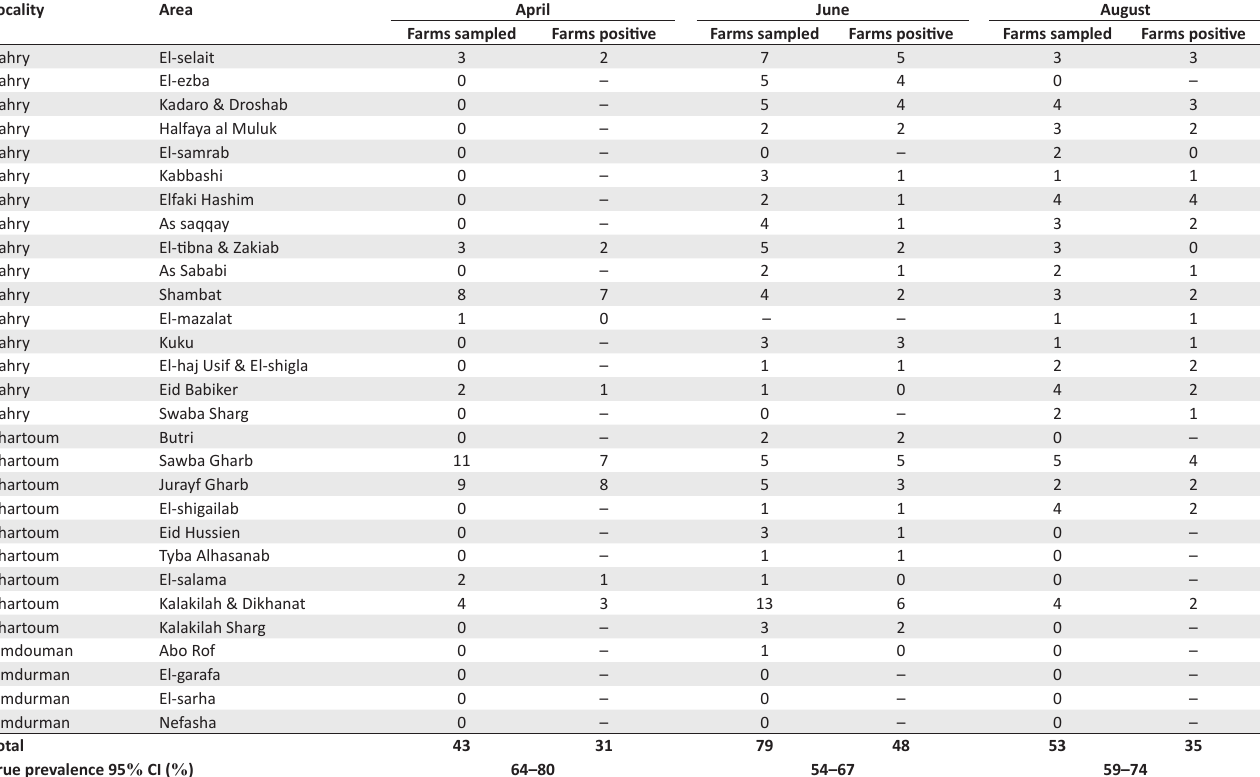
TABLE 2: Number of farms sampled in 2008 and found positive for antimicrobial residues in each area sampled with 95 % confidence interval for the true prevalence of farms with residues for each period sampled given below. Locality Area